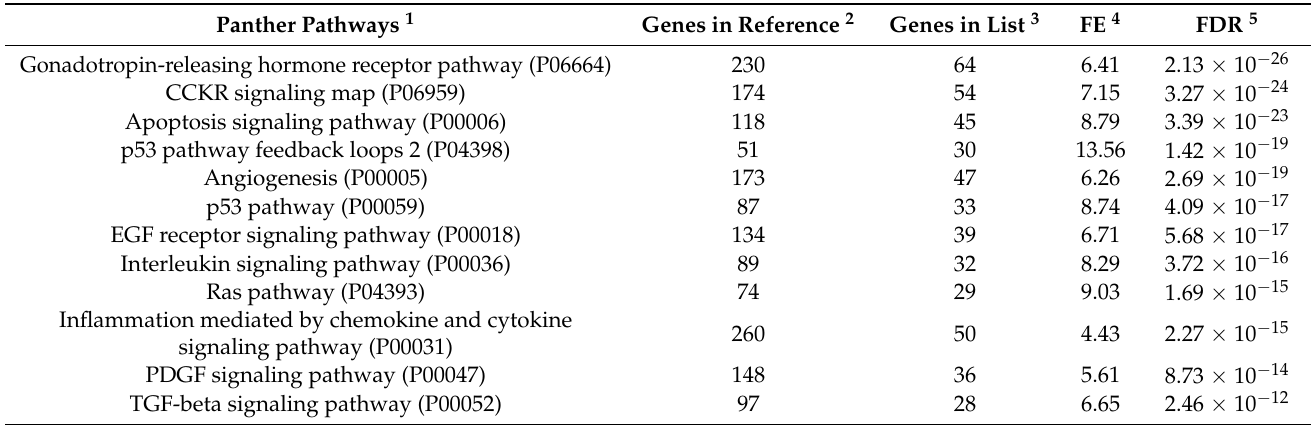
Table 1. Enrichment analysis results. Table shows top 20 pathways enriched (FDR < 0.05) in the list of target genes. Fold enrichment (FE) values greater than 1 indicate that the pathway annotation is overrepresented in the experiment and less than 1 indicates that it is